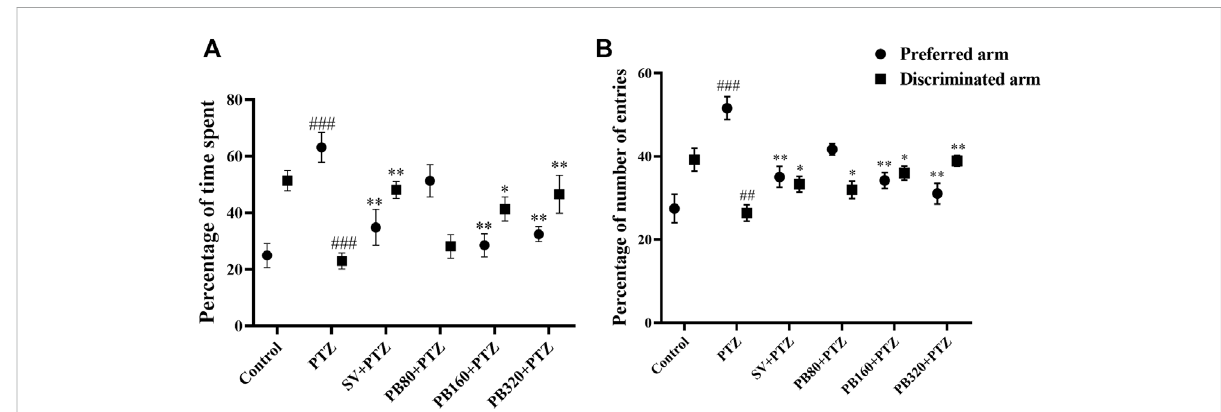
FIGURE 5 Theaqueousextract of P.biglobosa increased boththepercentage oftime spent (A) andthepercentagenumberofentriesinthediscriminated arm (B) in the T-maze test. Results are expressed as mean percentage ± SEM, N = 8. Data were analyzed by one-way ANOVA, followed by Tukey (HSD). ### p < 0.001; ## p < 0.01 compared to the control group and ** p < 0.01; * p < 0.05 compared to the PTZ group. Control, normal control grouponlytreatedwithdistilledwater;PTZ,negativecontrolgrouptreatedwithdistilledwaterandPTZ;PB80,PB160,PB320+PTZ,testgroups treated with the aqueous extract of P. biglobosa (80, 160, and 320, respectively) and PTZ; SV + PTZ, positive control group treated with sodium valproate and PTZ. PTZ, pentylenetetrazole. SV, sodium valproate; PB, Parkia biglobosa